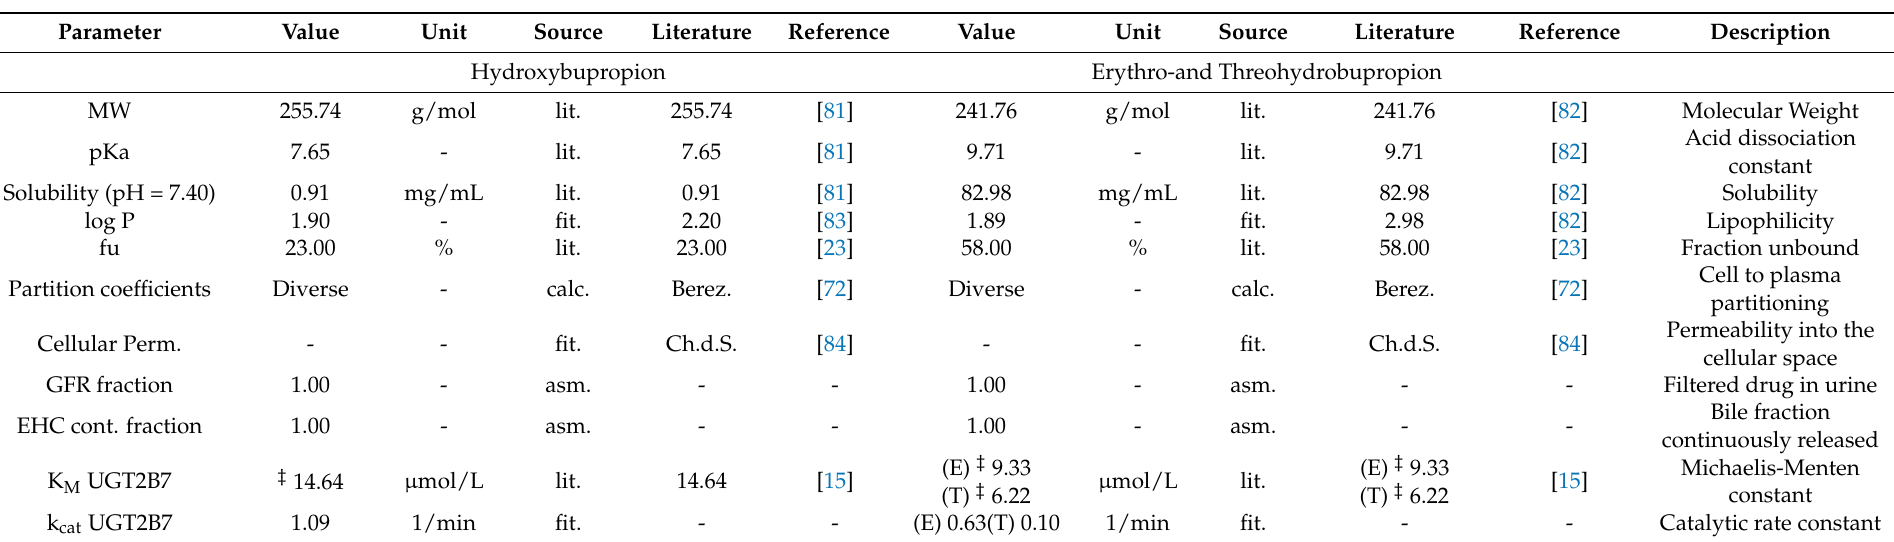
Table 2. Drug-dependent parameters of the hydroxybupropion, erythrohydrobupropion and threohydrobupropion PBPK